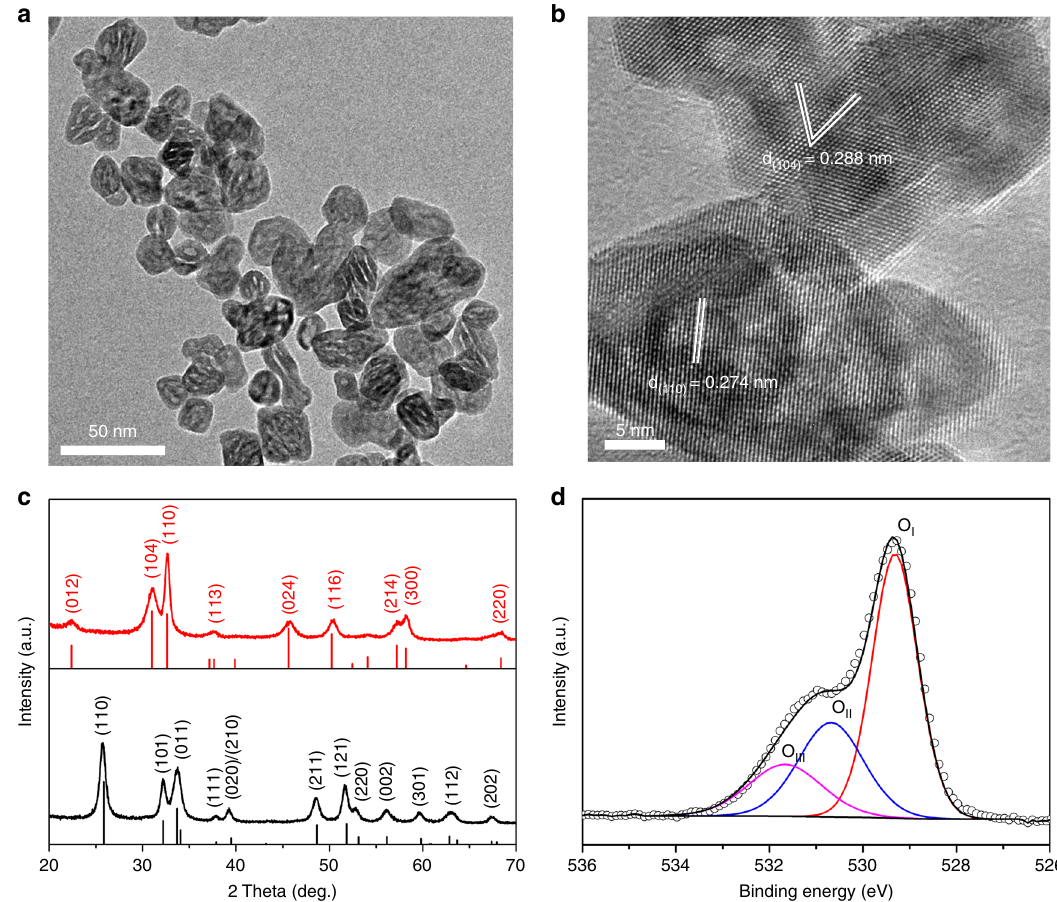
Fig. 1 Structural characterizations of InOOH precursor and rhombohedral In 2 O 3-x (OH) y nanocrystals. a TEM image of rh-In 2 O 3-x (OH) y nanocrystals. b HRTEM image of rh-In 2 O 3-x (OH) y nanocrystals. c PXRD patterns of InOOH precursor (black) and rh-In 2 O 3-x (OH) y nanocrystals (red). d High-resolution O 1 s core level XPS spectra for rh-In 2 O 3-x (OH) y nanocrystals